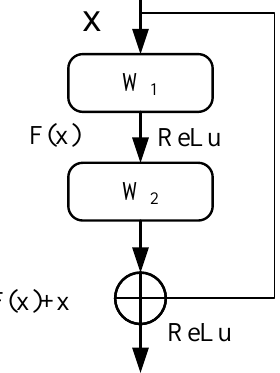
Figure 2. Residual structure. x l is the input vector of residual unit. W l and W 2 represents weight matrices. F ( x ) is residual